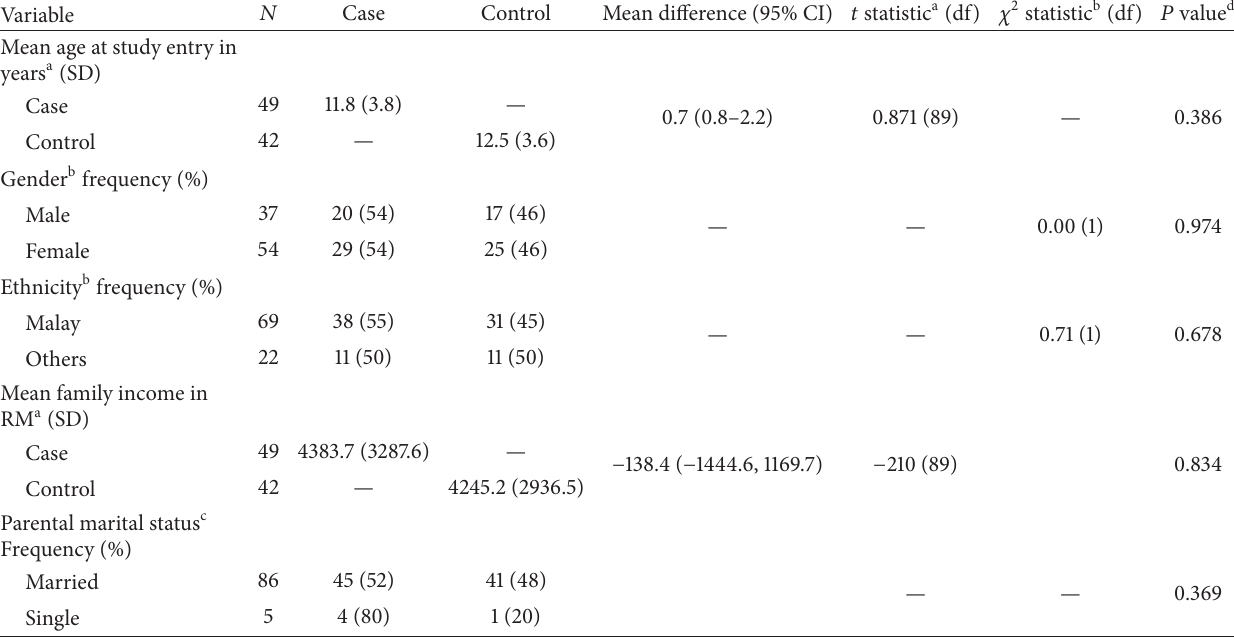
Table 2: Sociodemographic characteristics of study